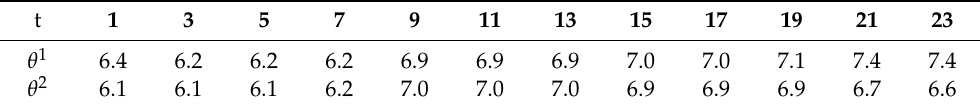
Table 1. The coefficient θ t of the utility function (44) of Consumers 1 and